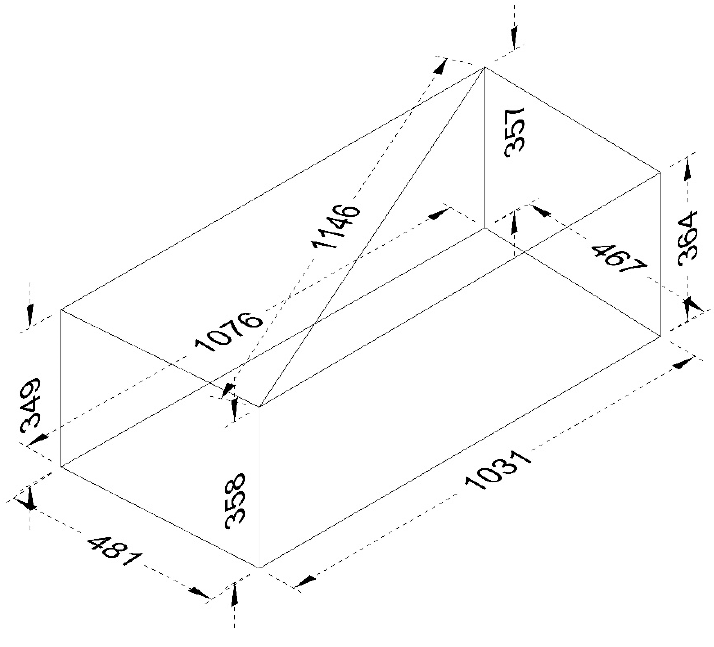
Figure 6. SB01 dimensions.